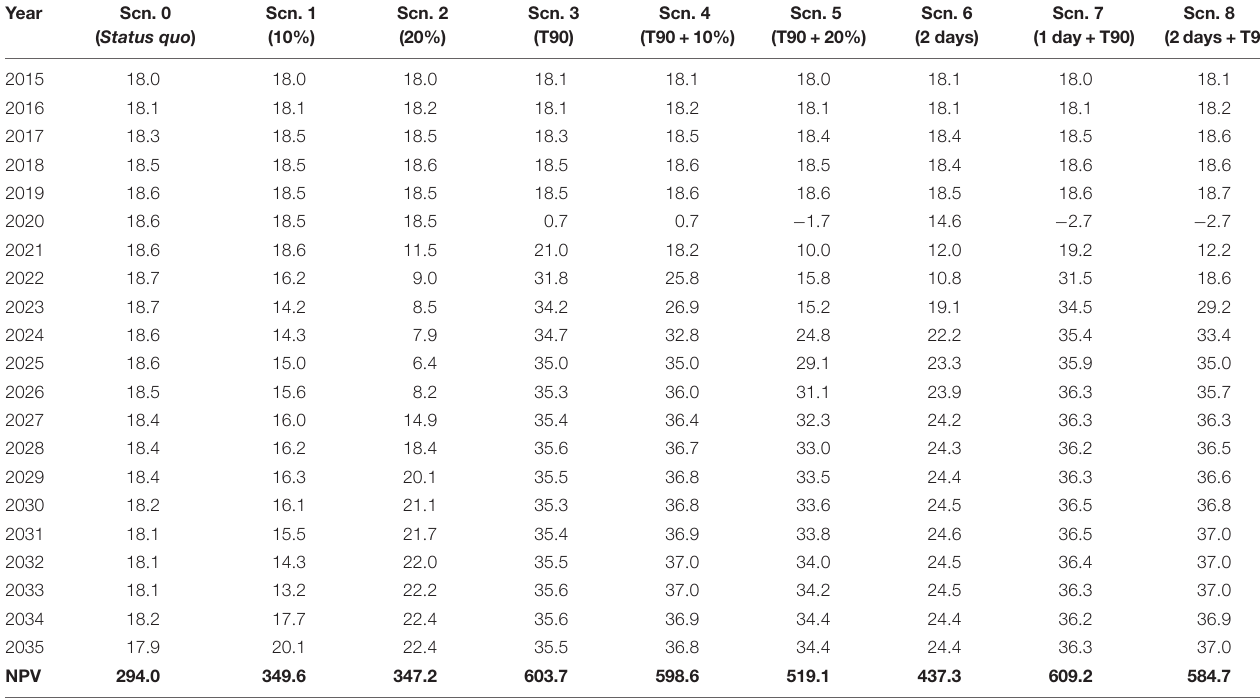
TABLE 6 | Average net present values (NVP) for net profits of demersal fleet according the introduction of the different management measures in 2020 (Scenarios 1–8). Year Scn. 0 Scn. 1 Scn. 2 Scn. 3 ( Status quo ) (10%) (20%)